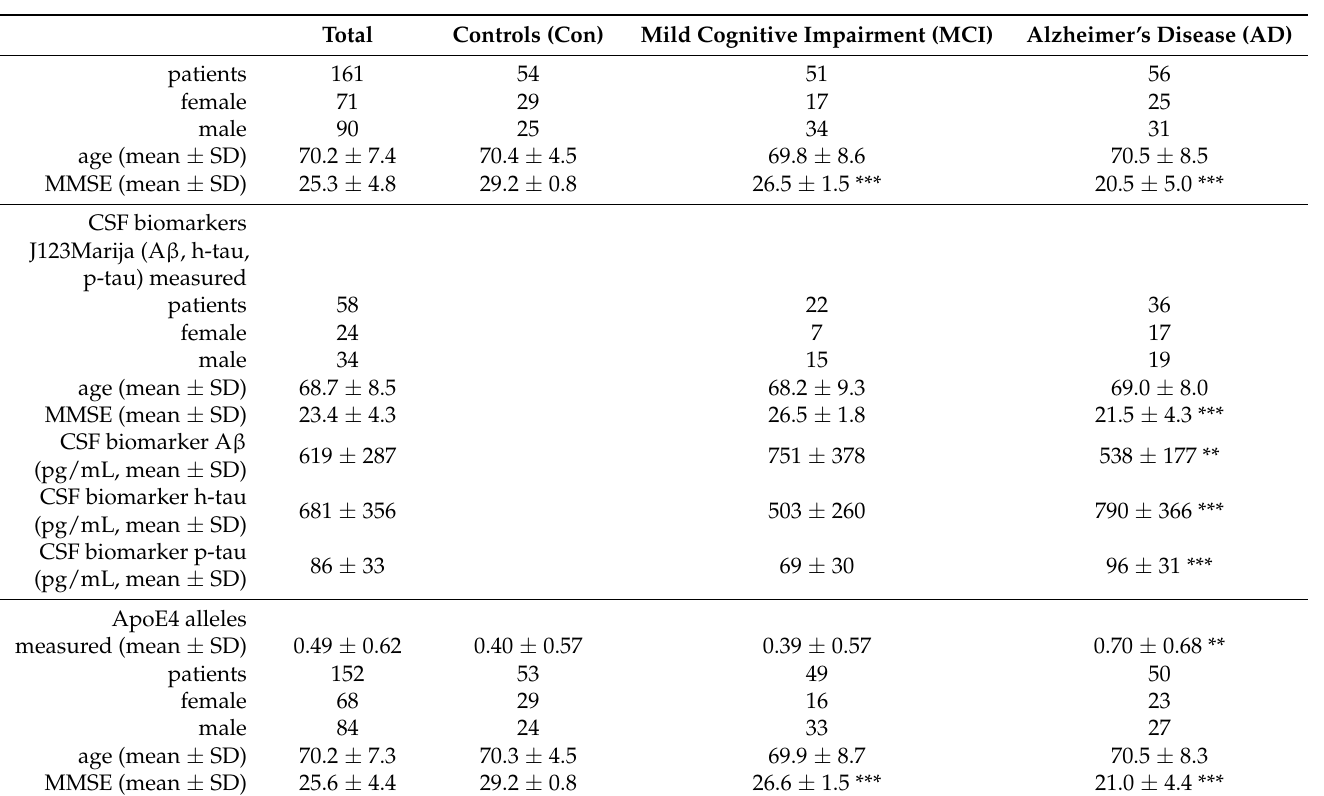
Table 1. Clinical data of the study cohort including readings of CSF biomarkers (A β 1-42, h-tau, p-tau) for the three studied groups–Alzheimer’s disease (AD) and mild cognitive impairment (MCI) diagnosed patients, and control samples